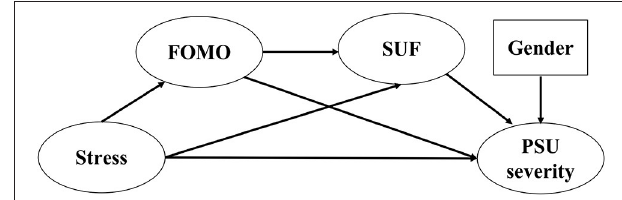
TABLE 1 | Mean, standard deviation, and correlation analysis of each variable.